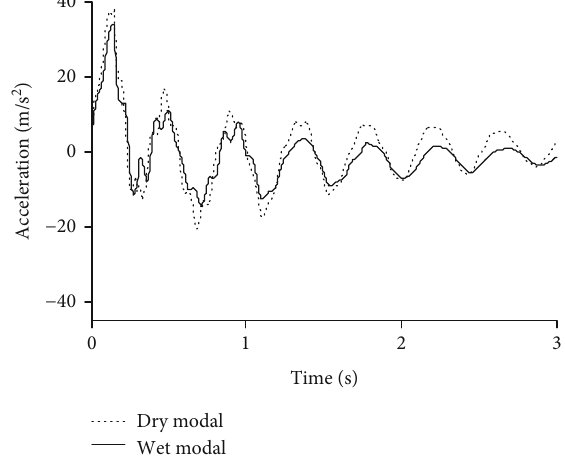
Figure 8: Transient response of acceleration at the center of gravity.